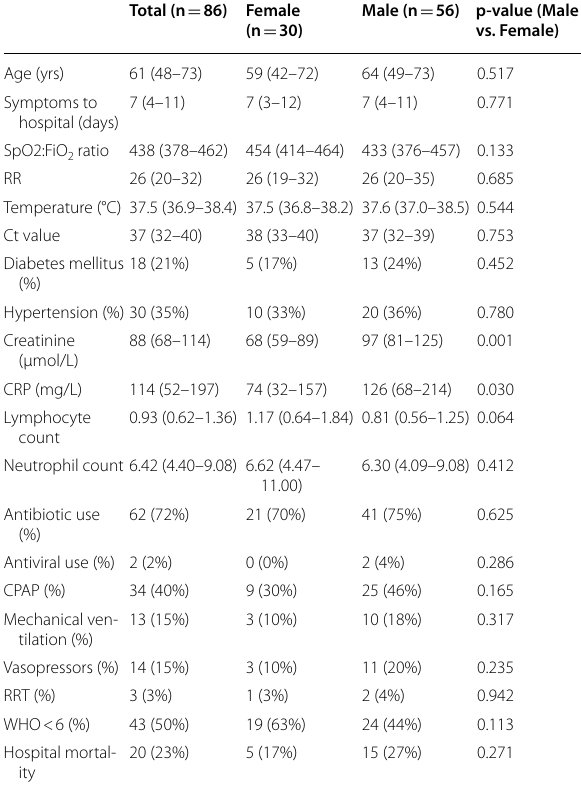
Table 1: Demographics and outcomes. Conclusion. Many cytokines were more pronounced in males, explaining some of the marked sex variances in treatment responses noted in COVID-19 RCTs. Age and aggressive respiratory illness tra- jectory but not seroconversion on hospital admission were mortality risk